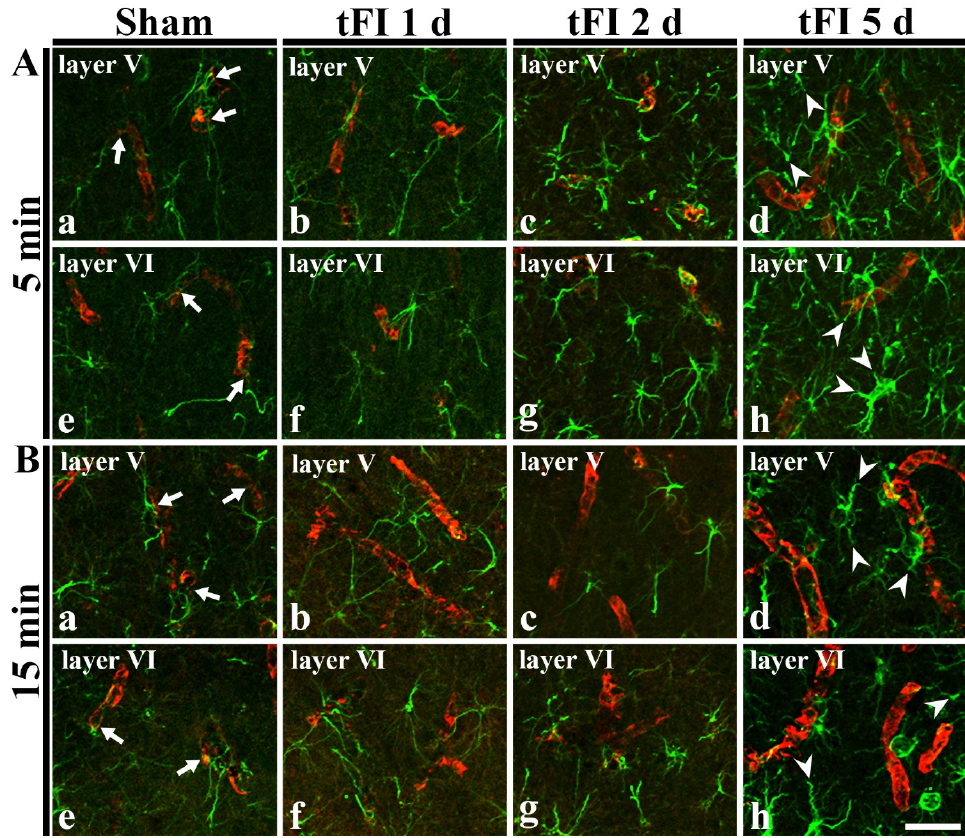
Figure 7. Double immunohistofluorescence for AEf around blood vessels in layers V and VI using anti-GFAP (green) and GLUT-1 (red) in the mild ( A ) sham ( Aa , Ae ), mild tFI ( Ab – Ad , Af – Ah ), se- vere ( B ) sham ( Ba , Be ), and severe tFI ( Bb – Bd , Bf – Bh ) groups at one day ( Ab , Af , Bb , Bf ), two days ( Ac , Ag , Bc , Bg ) and five days ( Ad , Ah , Bd , Bh ) after tFI. In all sham groups, GFAP-AEf (arrows) contact GLUT-1-endothelial cells. On day 5 after tFI, GFAP-AEf (arrowheads) around GLUT-1-endothelial cells apparently disappear in both groups. Scale bars = 50 μ m.